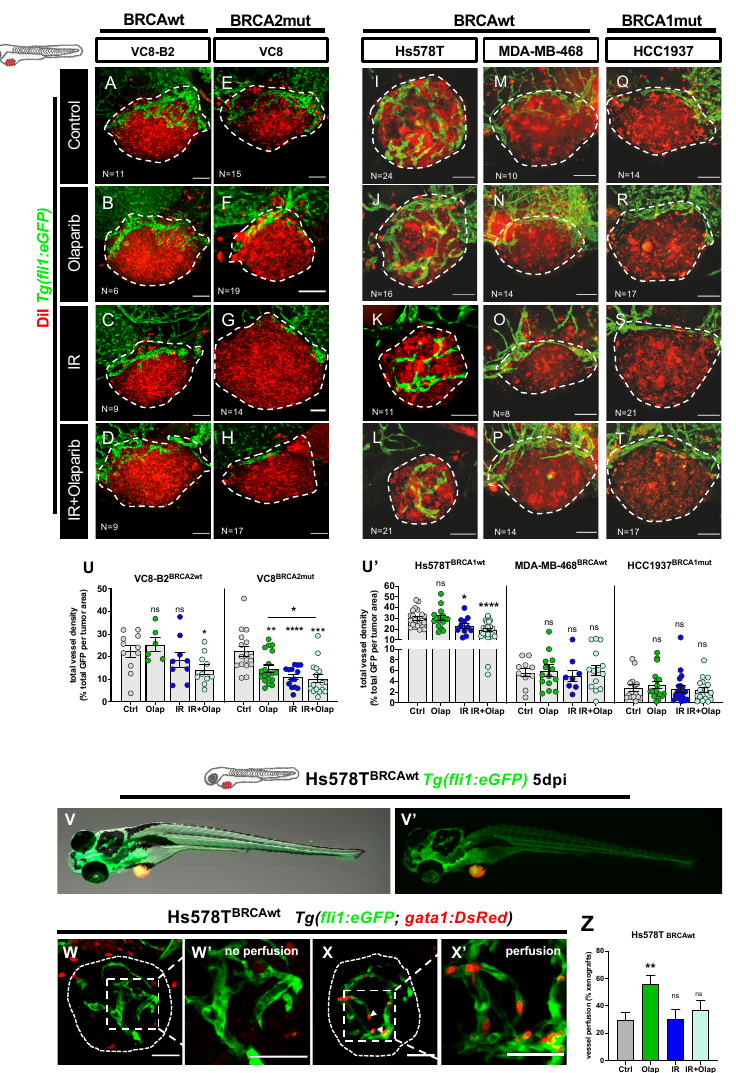
Figure 4. Olaparib and IR can have modulating e ff ects on the tumor vascular network. All cell lines were fluorescently labeled with CM-DiI (in red) and injected in the perivitelline space (PVS) of 2dpf Tg(fli1:eGFP) zebrafish embryos. At 24 hpi, zebrafish xenografts were screened and randomly distributed into the di ff erent experimental conditions: control, olaparib, IR, IR + olaparib. Xenografts were treated for 4 consecutive days, fixed at 5dpi and imaged by confocal microscopy for analysis of vessel density ( A – T ). The quantification of vessel density is represented by percentage of tumor area occupied by vessels (in green) ( U ). To analyze vessel functionality, TNBC cell line Hs578T was fluorescently labeled with CellTracker ™ Deep Red Dye (in red-false color) and injected in the PVS of 2dpf Tg(gata1:RFP;fli1:eGFP). Hs578T xenografts were screened and randomly distributed in the di ff erent experimental conditions: control, olaparib, IR and IR + olaparib. Representative images of 5dpi Hs578T xenografts ( V , V’ ). The presence of erythrocytes (in red) inside the tumor-associated vessels (in green) was scored as: absence of erythrocytes = no perfusion ( W , W’ ) or presence of erythrocytes = with perfusion ( X , X’ ) and quantified ( Z ). All images are anterior to the left, posterior to right, dorsal up, and ventral down (as depicted in the scheme on top left). The dashed lines delineate the tumor area. White arrowheads indicate erythrocytes inside the vasculature. Scale bar: 50 µ m. Results are from three independent experiments and expressed as mean ± SEM, each dot represents one xenograft. The total number of xenografts analyzed is indicated in the images. Statistical results: ns > 0.05, * p ≤ 0.05, ** p ≤ 0.01, *** p ≤ 0.001, **** p ≤